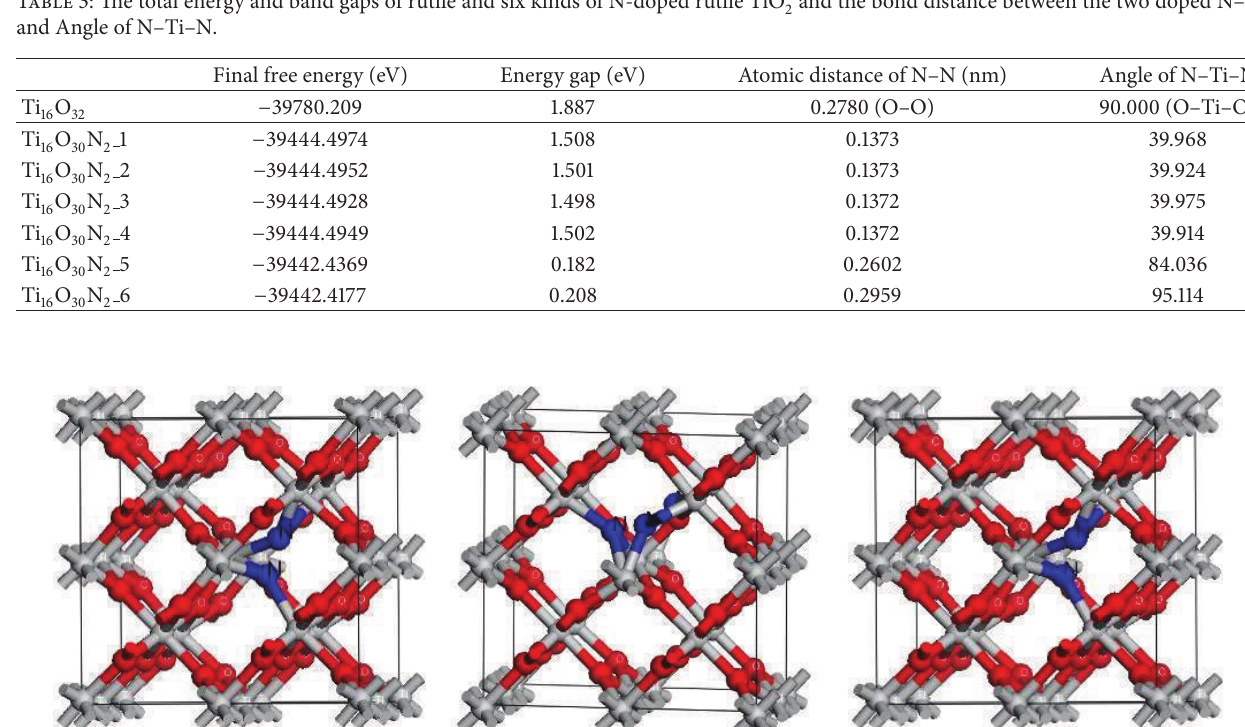
Table 2: The total energy and band gaps of rutile and four kinds of N-doped rutile TiO